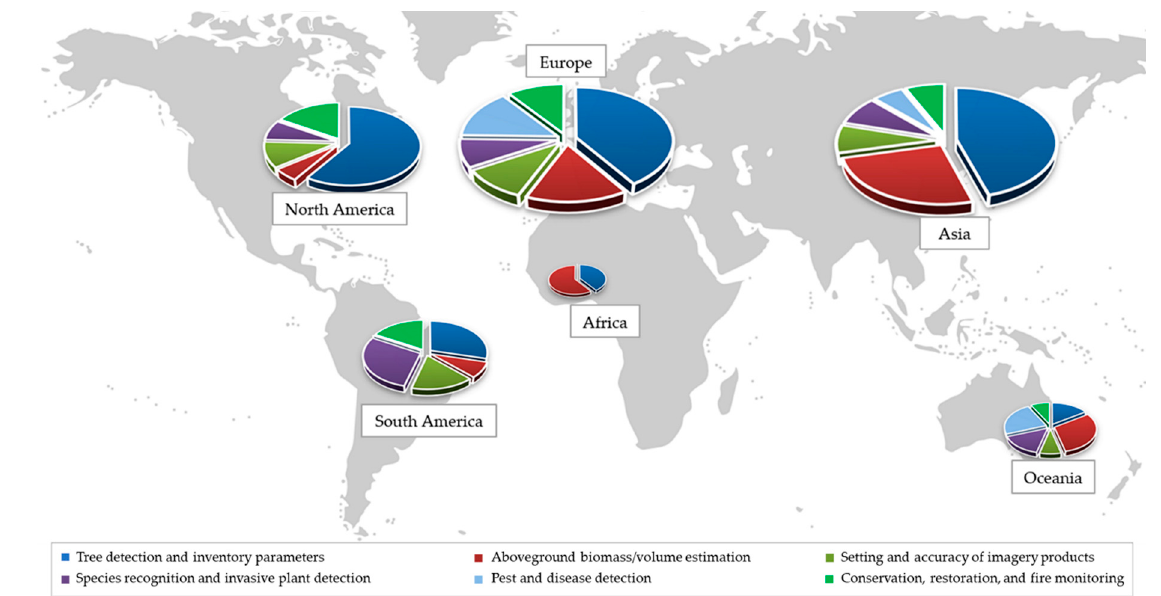
Figure 6. Geographic distribution of research works according to the research place. The pie chart size represents the number of papers while topics are highlighted in different colors.